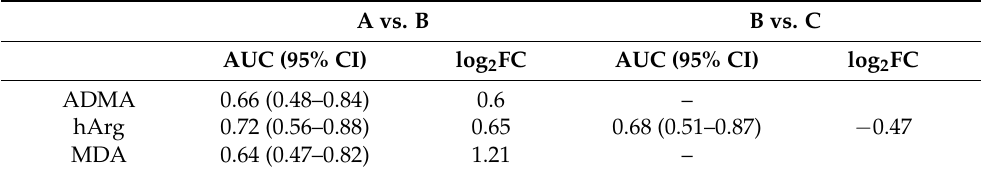
Figure 2. ROC curves of serum homoarginine (hArg), malondialdehyde (MDA) and asymmetric dimethylarginine (ADMA) and between comparisons of ( A ) group A vs. group B, and ( B ) between comparison of group B and group C for hArg. Table 3. Statistically significant metabolites highlighted after comparison of the examined groups. area under the curve (AUC) and their respective 95% confidence interval (CI) values and logarithm base two of the fold change